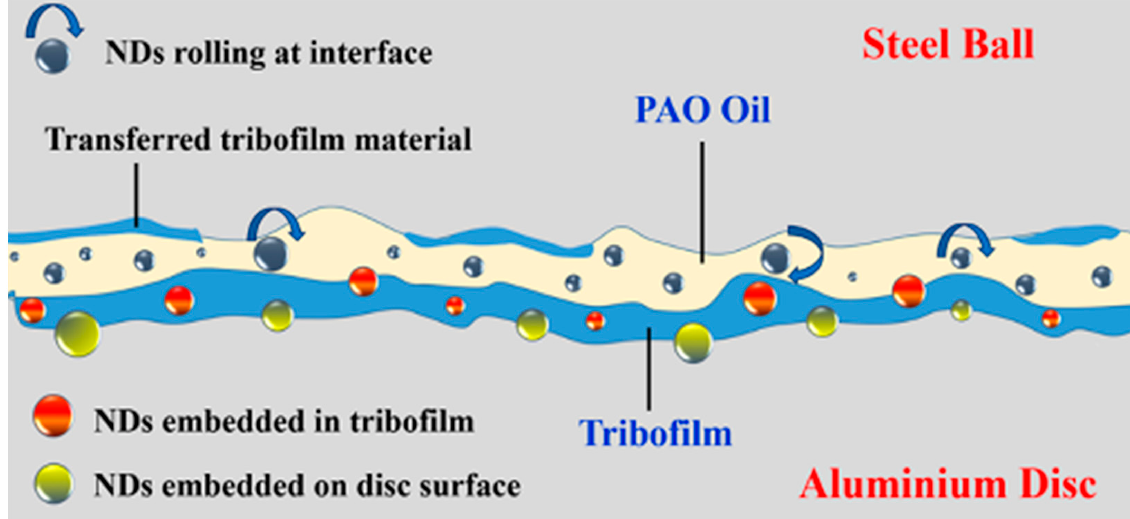
Figure 9. Schematic showing: (i) rolling of ND particles at interface (ball bearing effect); (ii) ND particles embedded in tribofilm; (iii) ND particles embedded on aluminium alloy disc surface; and (iv) transferred tribofilm material on steel ball surface (ND: nanodiamond).